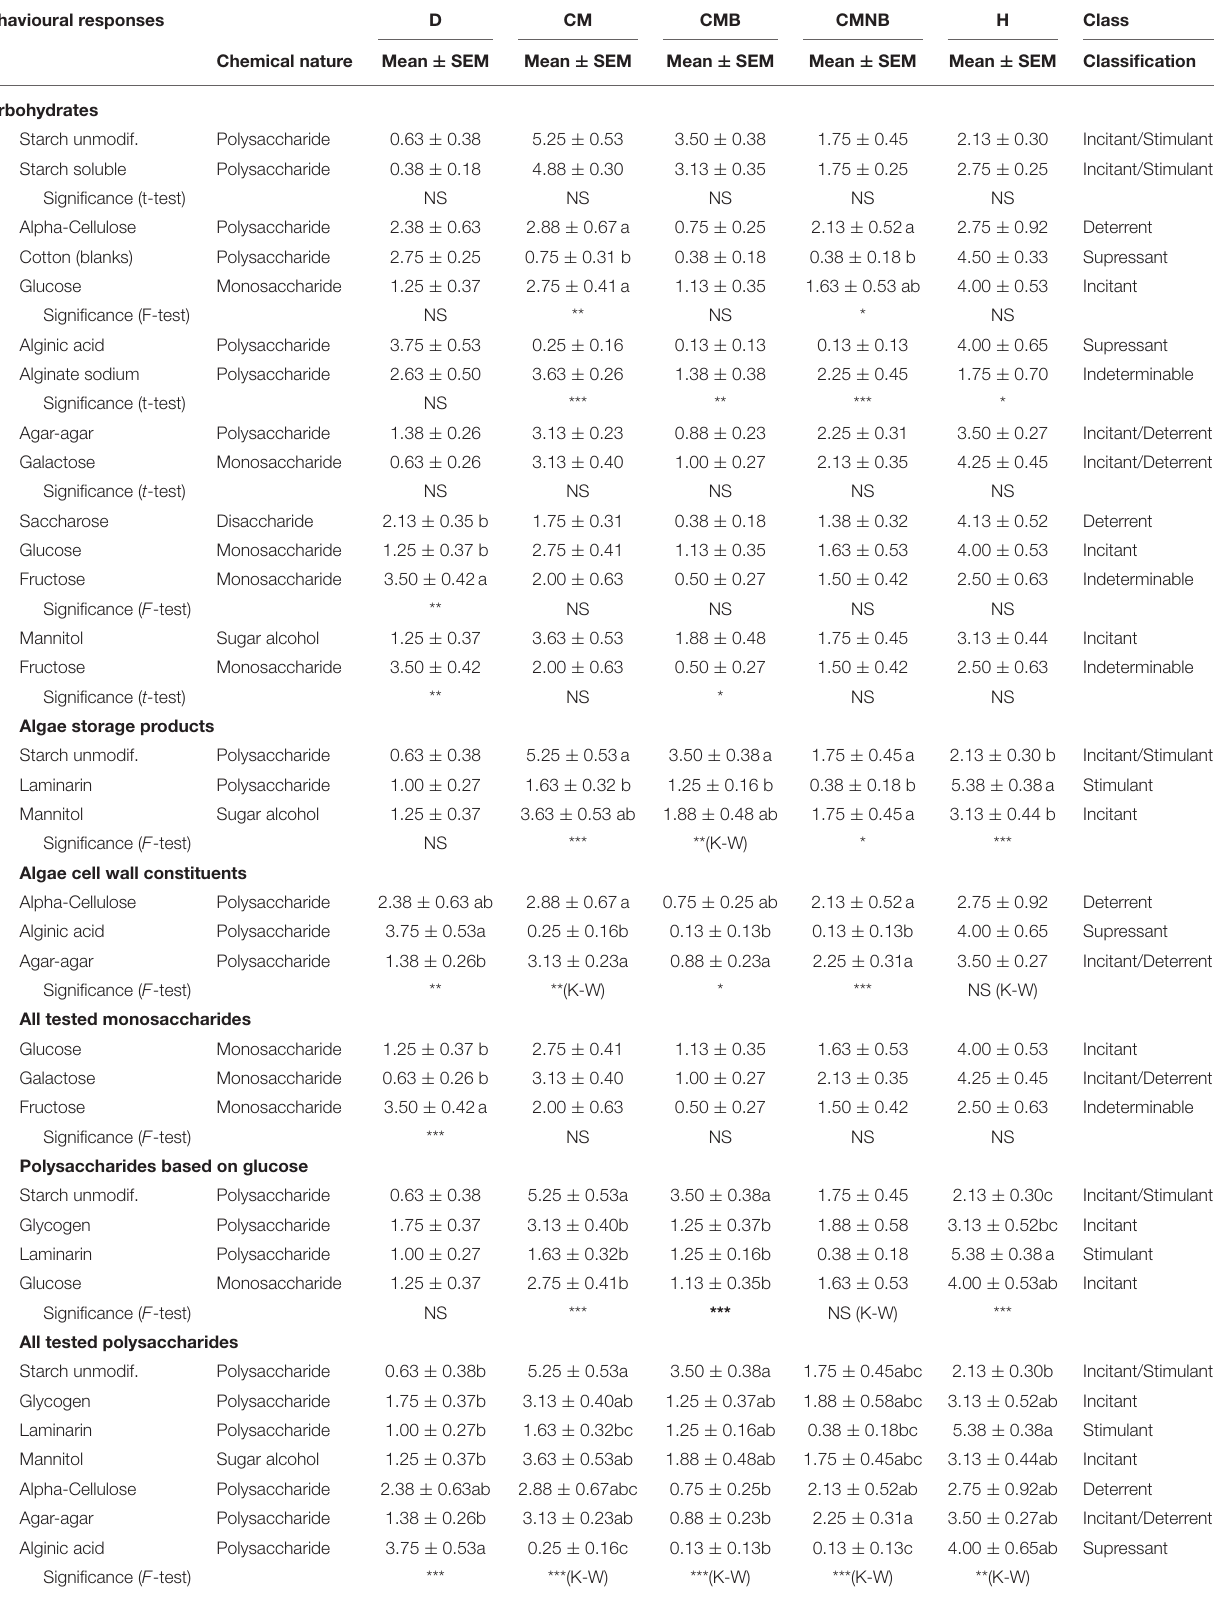
TABLE 6.1 | Comparisons of selected chemical stimuli by constituents or derivatives—carbohydrates. Behavioural